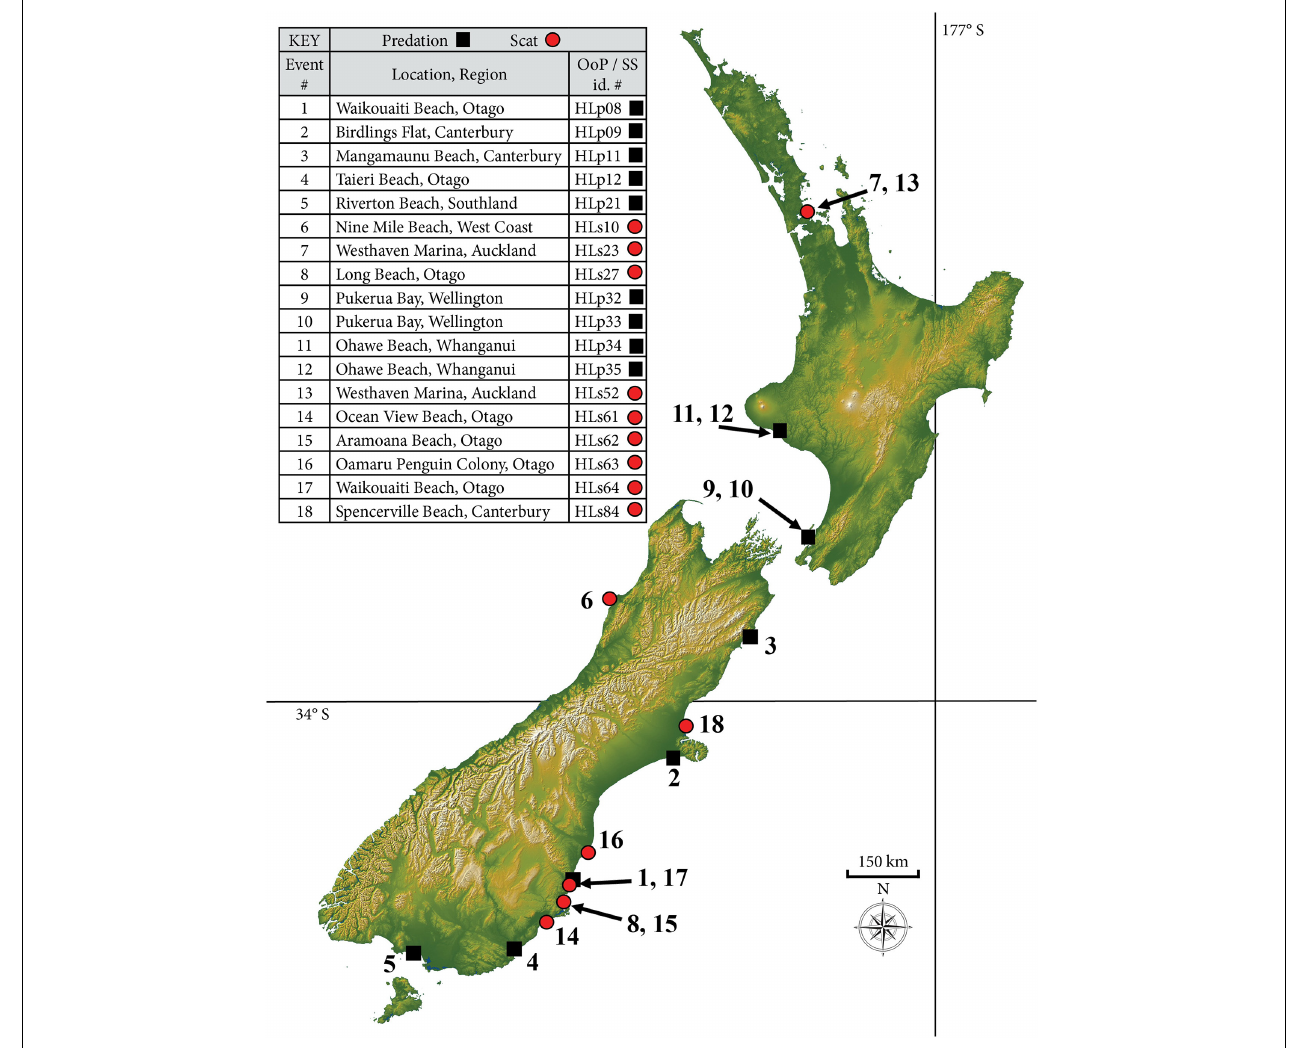
FIGURE 1 | Distribution of 18 leopard seal ( Hydrurga leptonyx ) predation events on chondrichthyans in New Zealand, indicating observations of predation (OoP, black squares) and scats (SS, red circles), noting that some locations contain more than one event. See methods for definition of regions. id. # is event